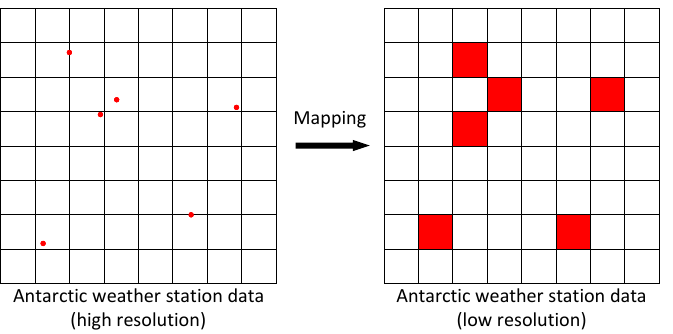
Figure 7. Map Antarctic station data into the grid-by-grid spatial pattern with 1.5° latitude × 1.5° longitude